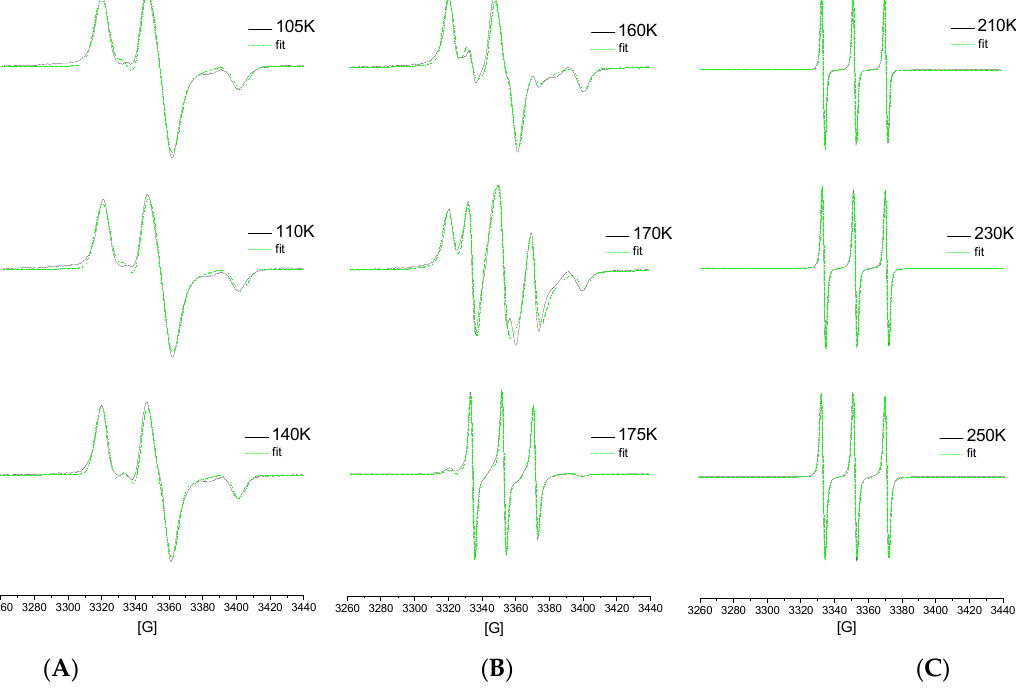
Figure 8. Experimental (black) and simulated (green) ESR spectra of the spin system TOL/TEMPO from three main regions of the two monomodal ( A , C ) and the one bimodal ( B ) type of ESR spectra.